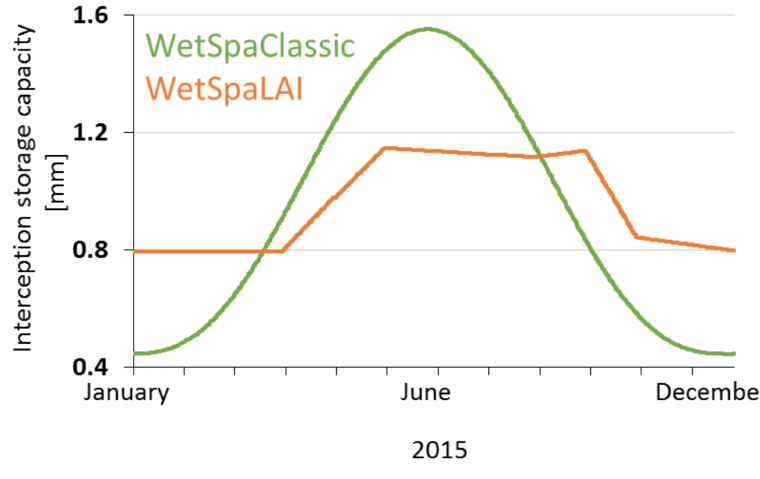
Figure 9. Comparison between WetSpaClassic and WetSpaLAI for the seasonal dynamics of the interception storage capacity for the Watermaelbeek in